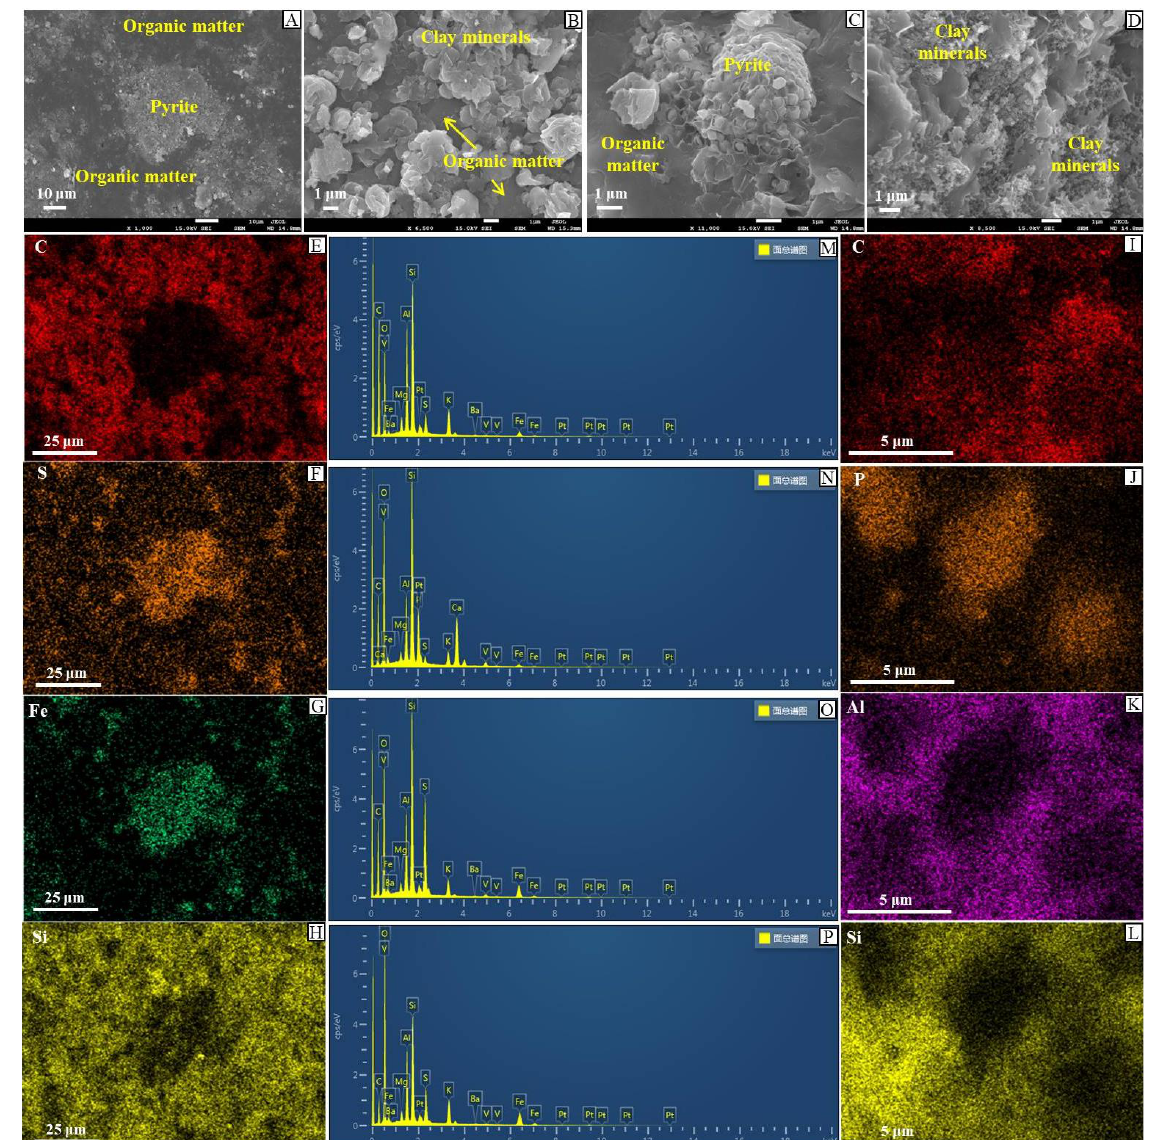
Figure 11. SEM images of the Early Cambrian black shale. ( A , B ) Samples from well ZK102; ( C , D ) sample from the Songlin section; ( E – H ) distributions of C, S, Fe, and Si corresponding to subgraph A; ( I – L ) distributions of C, P, Al, and Si corresponding to subgraph D; ( M – P ) energy spectra of subgraphs ( A – D ), respectively.